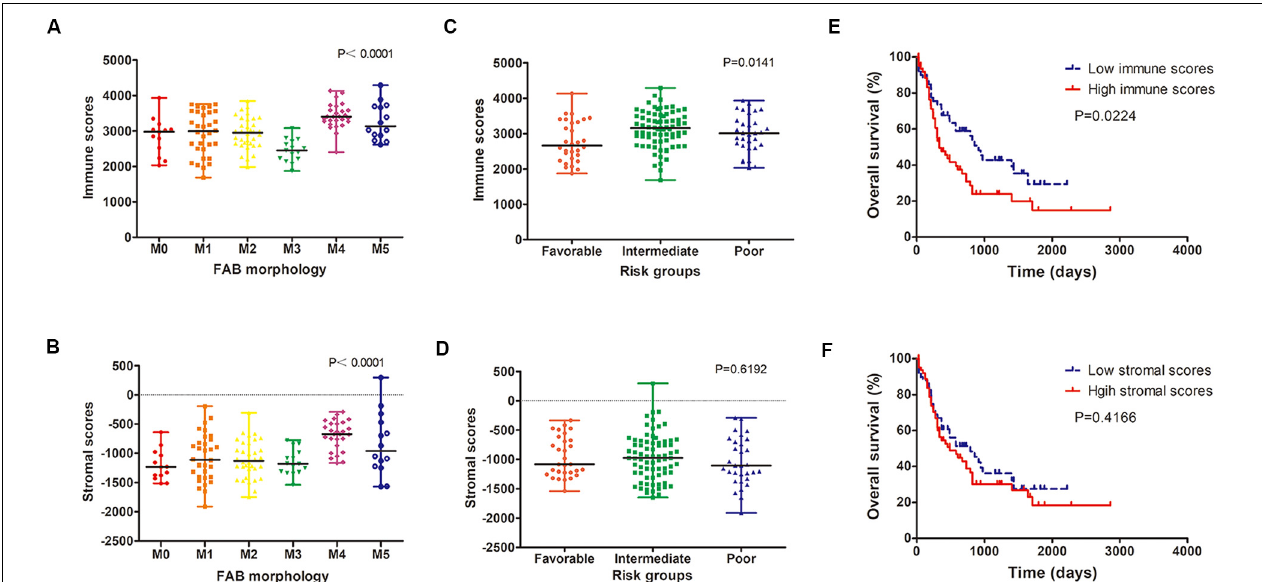
FIGURE 1 | Immune and stromal scores are associated with AML clinical parameters. (A,B) Distribution of immune scores (A) and stromal scores (B) for AML FAB subtypes. (C,D) The correlation between immune scores (C) and stromal scores (D) and AML cytogenetic risk. (E,F) Kaplan–Meier survival curve based on immunes (E) and stromal scores (F) . AML, acute myeloid leukemia.